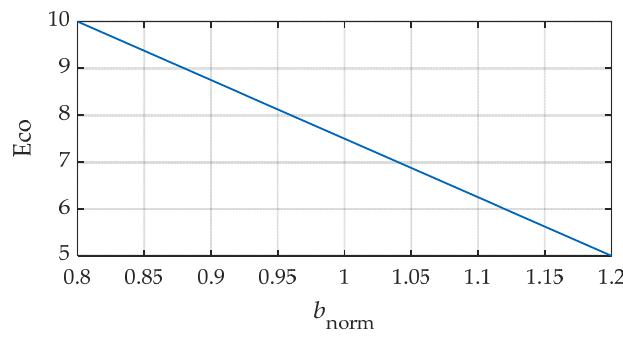
Figure 8. Scaling of the economy indicator.